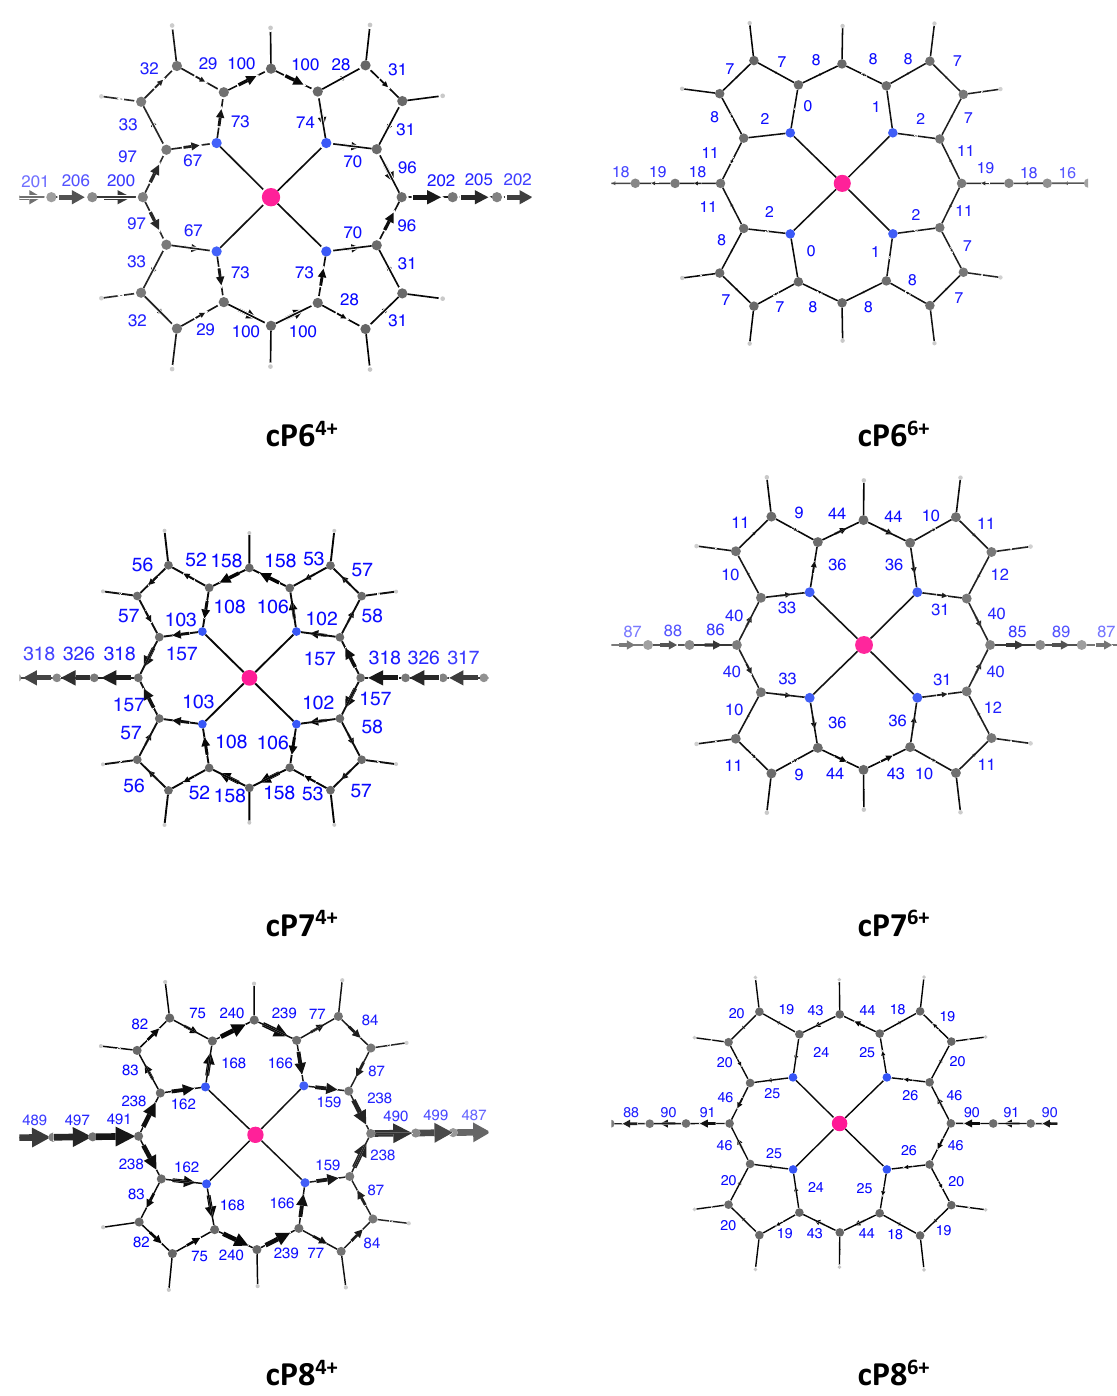
Figure 2. Current strengths in units of percent relative to the benzene current strength on a bis-ethyne cycloporphyrin unit of the six molecules studied. The magnetic field is oriented upwards and the center of the nanoring is behind the paper, so that arrows directed towards the right denote a paratropic current and arrows directed towards the left denote a diatropic